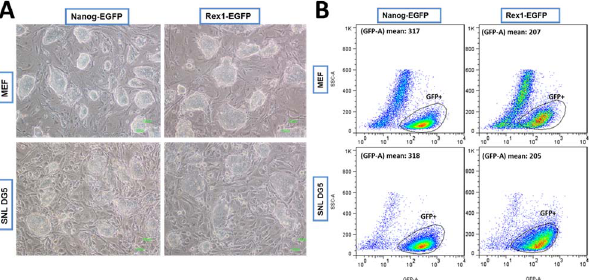
Fig. 4. SNL DG5 feeder could maintain ES cell pluripotency. (A) Cell morphology of NG2S and RGOC ES cell line grown on MEF and SNL DG5 feeder layers. The colonies are shown by phase contrast microscopy with 10x objective, and the scale bar is 100 m m. (B) Flow cytometry analysis of two ES cell lines (Nanog- EGFP, Rex1-EGFP) after three passages cultured on MEF and SNL DG5 feeder